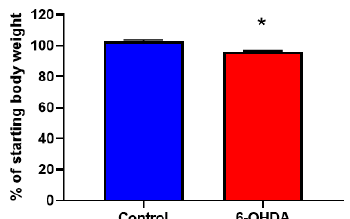
Figure 1. Chemical denervation with 6-hydroxydopamine (6-OHDA) significantly reduced body weight in Blood Pressure High/2J (BPH/2J) mice, n = 4 mice/group. * p < 0.002; all data presented as mean ± standard error of the mean (SEM).